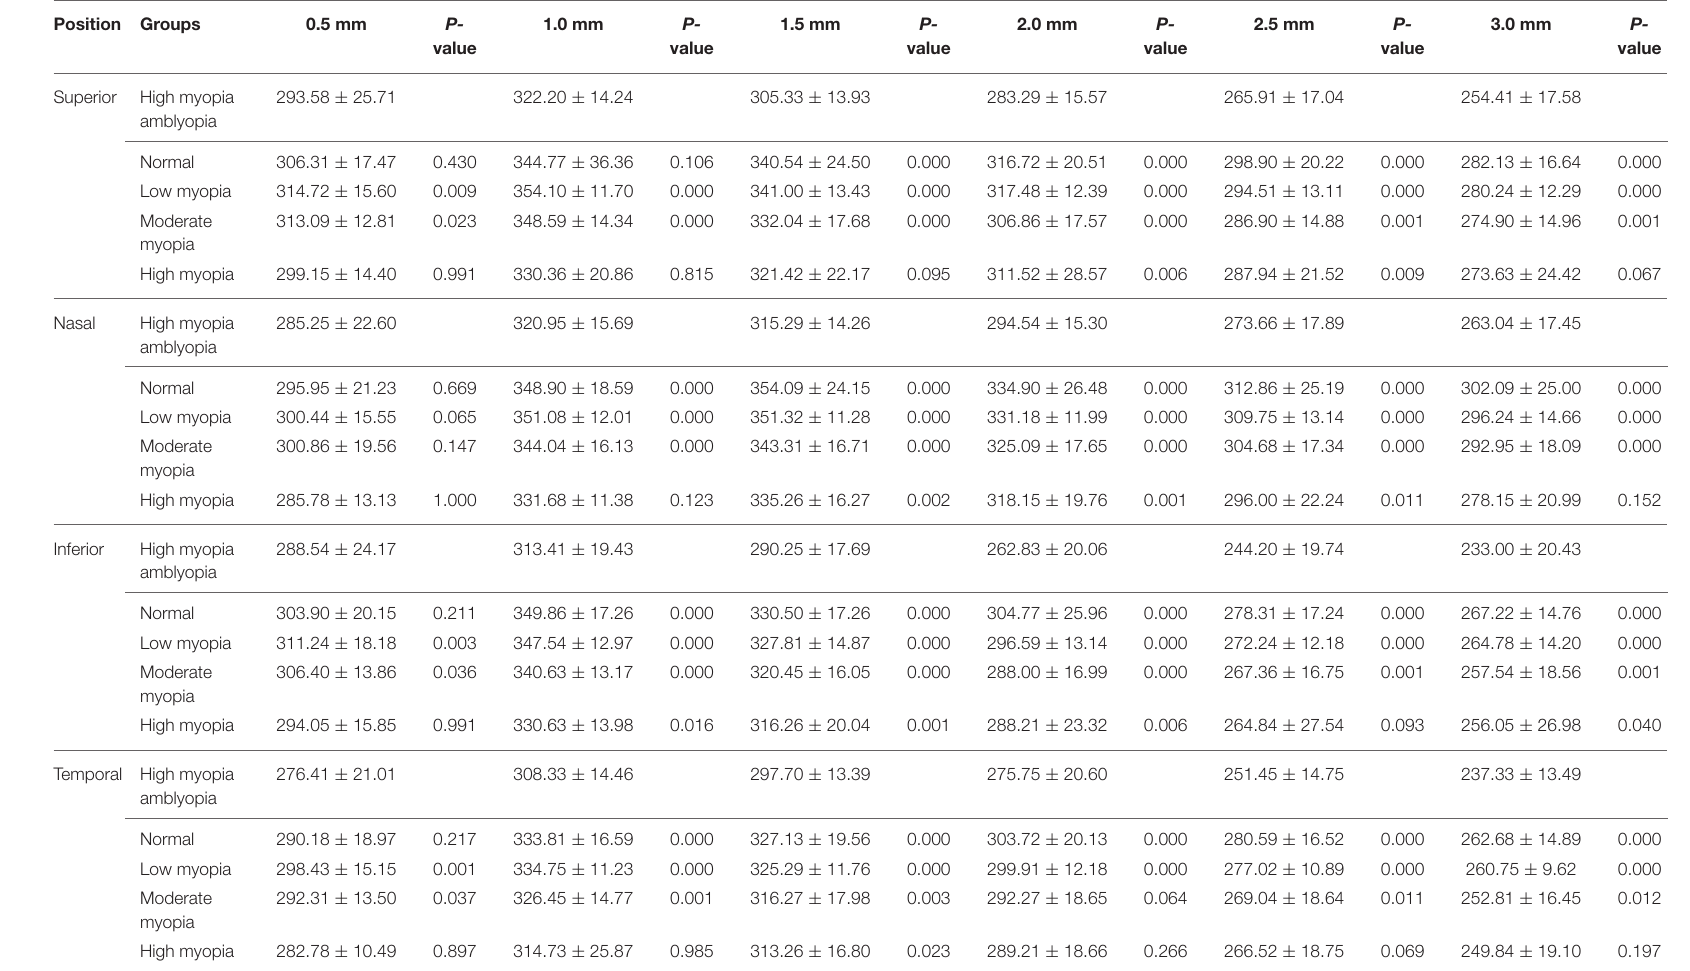
TABLE 3 | Retinal thickness in each